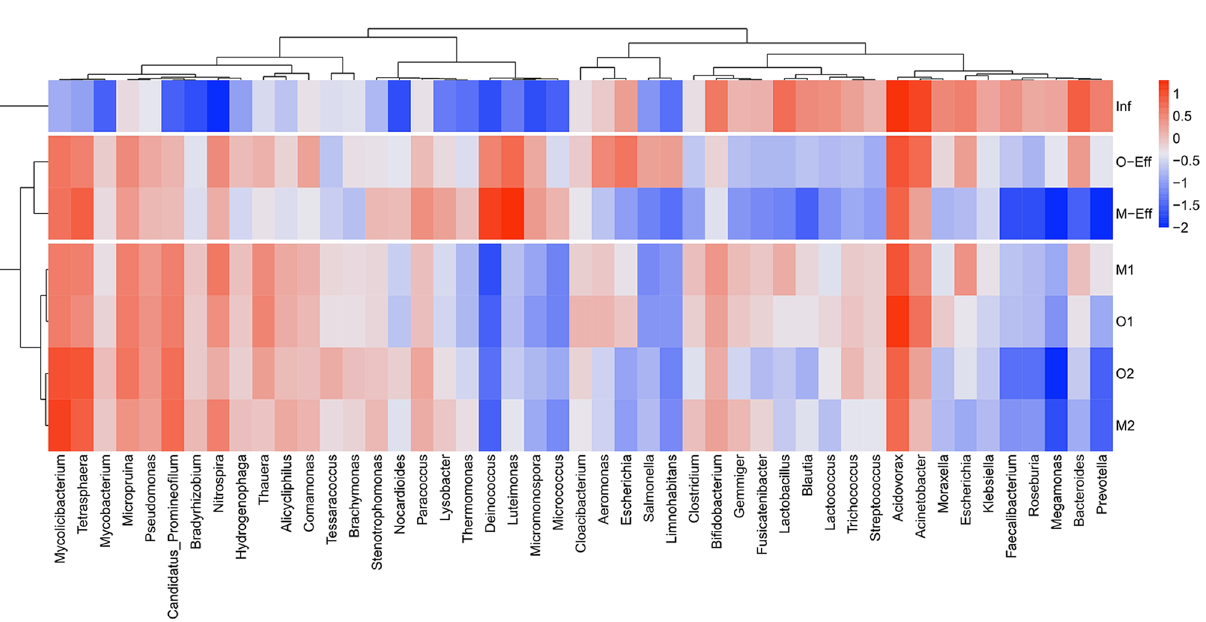
Figure 2. Community structure at the genus level in the OD and MBR